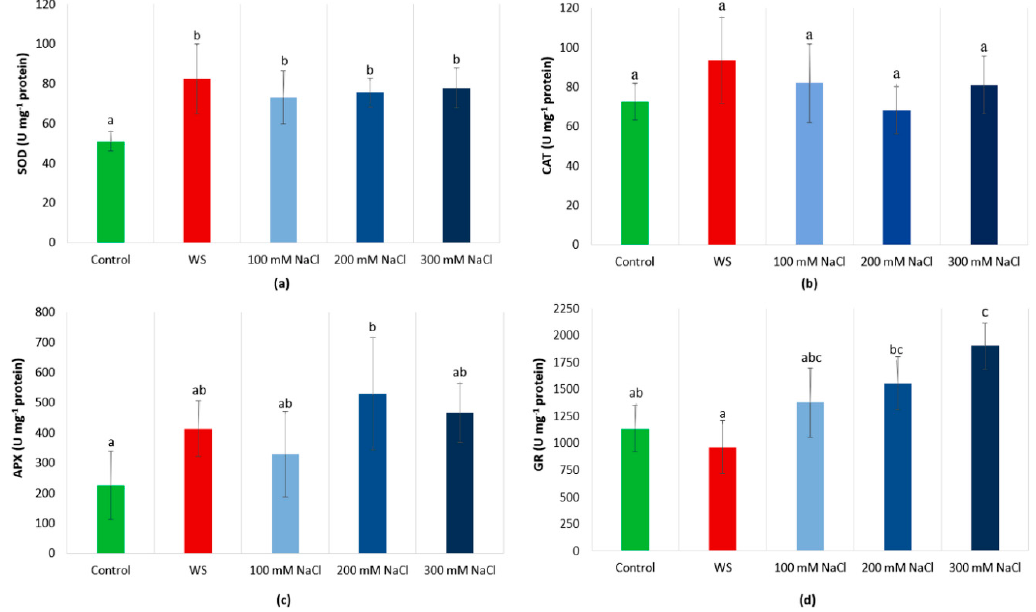
Figure 8. ( a ) Superoxide dismutase (SOD)-, ( b ) catalase (CAT)-, ( c ) ascorbate peroxidase (APX)- and ( d ) glutathione reductase (GR)-specific activities in needle protein extracts of one-year-old A. alba seedlings after 30 days of growth in the presence of the indicated NaCl concentrations or subjected to water deficit stress (WS). Bars represent means ± SE ( n = 7). Different letters above the bars indicate significant differences between treatments, according to Tukey’s test ( α = 0.05).